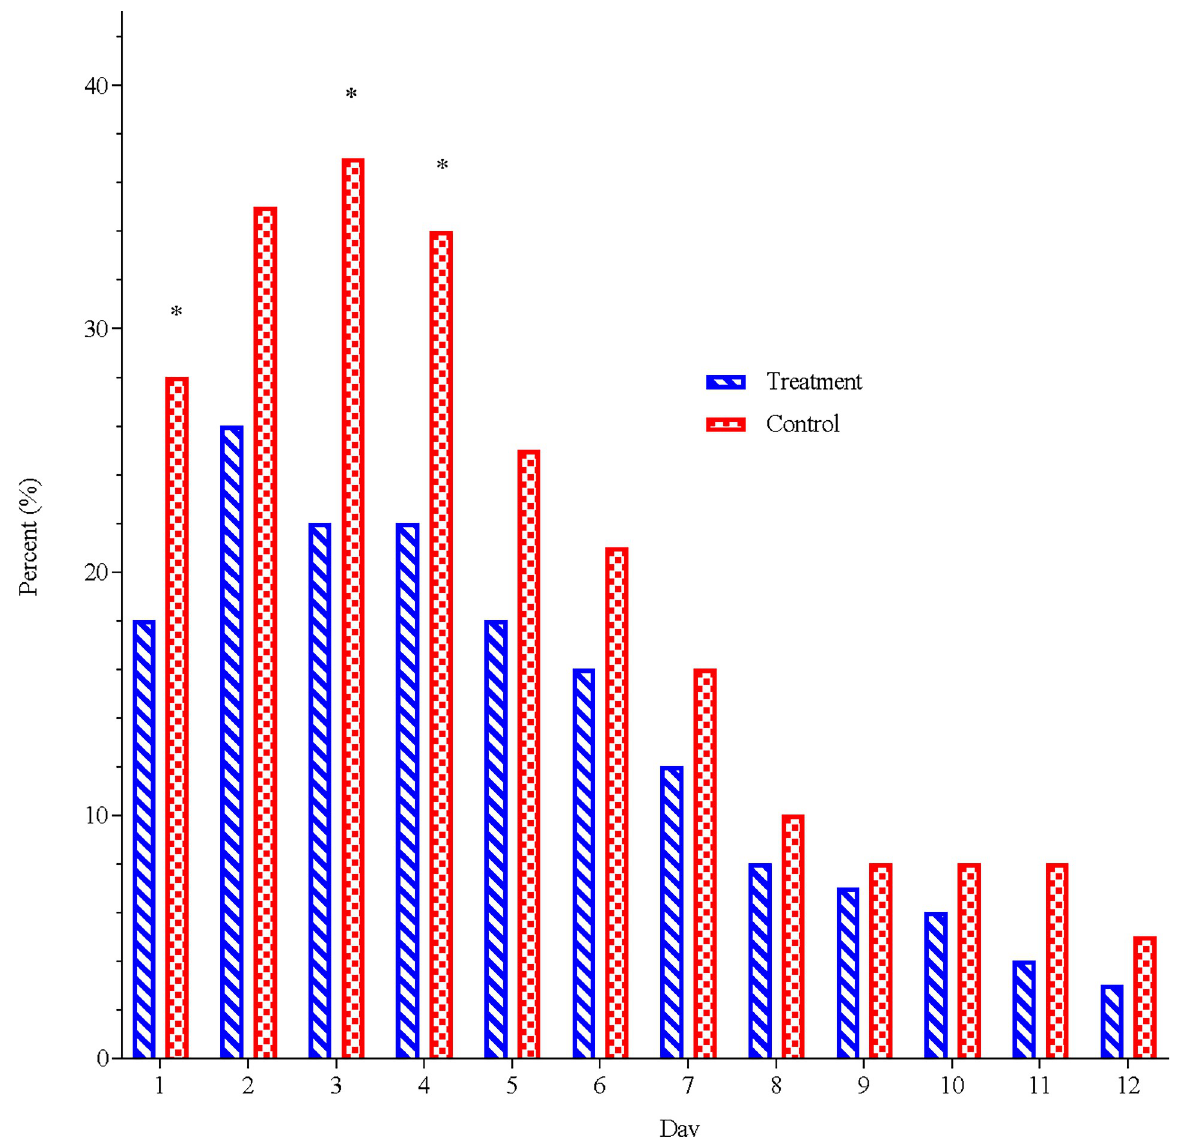
Fig 4. Daily frequency of subjects using rescue